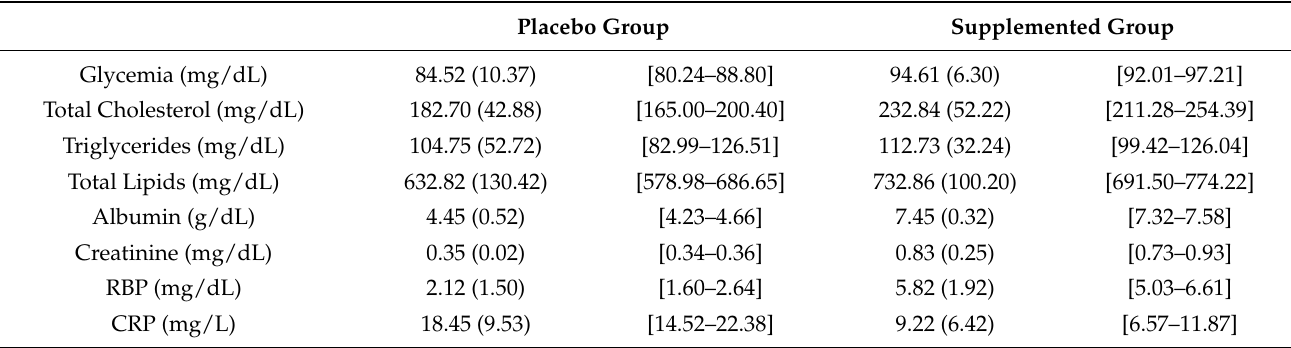
Table 3. Serum biochemical parameters. Values are expressed as mean.